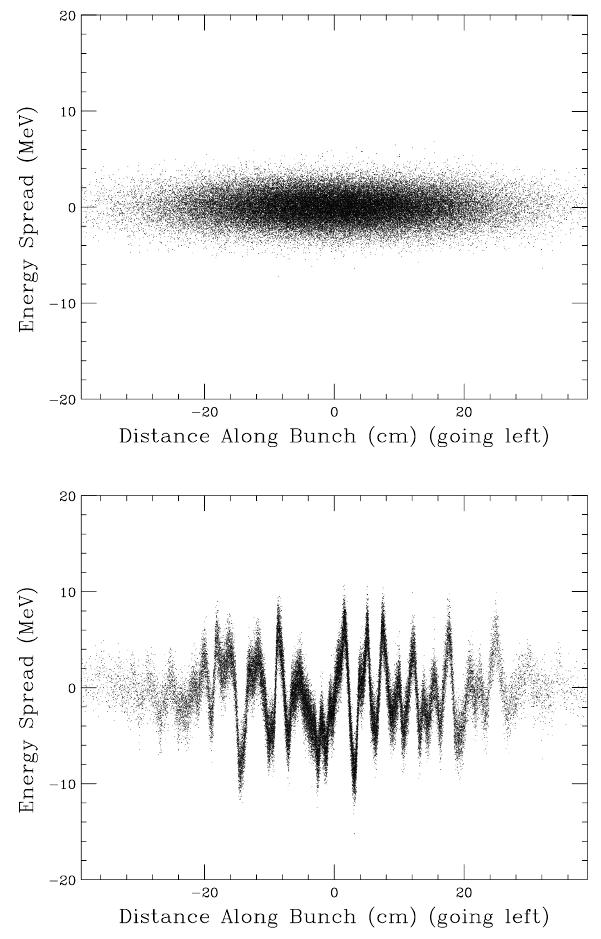
FIG. 5. (Color) Simulation of the 13-cm bunch of 4 3 10 12 muons subject to a broadband impedance with quality fac- tor Q (cid:1) 1 and Z k (cid:1) n (cid:1) 0.5 V at the resonant angular fre- quency v r (cid:1) 50 GHz. The half-triangular bin width is 15 ps (0.45 cm) and 2 3 10 6 macroparticles are used. The top plot shows initial distribution with s E (cid:1) 1.5 MeV and s (cid:1) (cid:1) 13 cm. The lower plot shows distribution after 1000 turns with compensating rf’s initially at v 1 (cid:1)(cid:2) 2 p (cid:3) (cid:1) 0.3854 GHz and v 2 (cid:1)(cid:2) 2 p (cid:3) (cid:1) 0.7966 GHz, voltages V 1 (cid:1) 65.40 kV and V 2 (cid:1) 24.74 kV, and phases w 1 (cid:1) 177.20 ± and w 2 (cid:1) 174.28 ± . The rf voltages decrease according to the decay of the